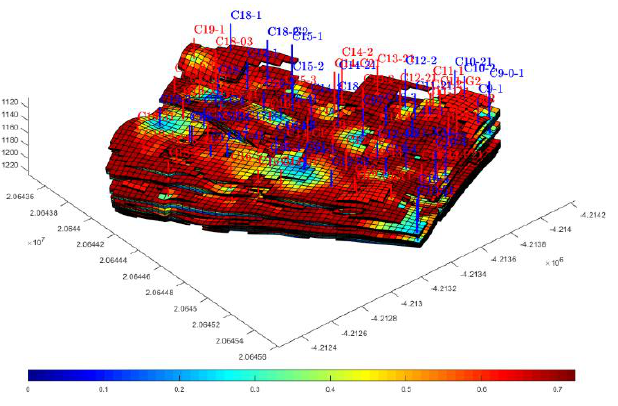
Figure 9. The remaining oil saturation distribution calculated by a traditional simulator.